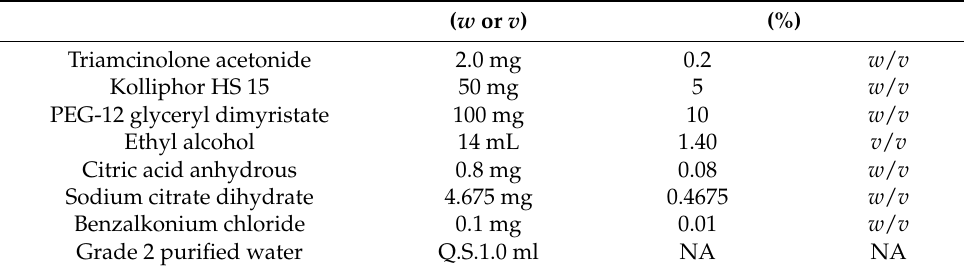
Table 1. Composition of triamcinolone acetonide-loaded liposome formulation (1 mL). ( w or v ) (%) Triamcinolone acetonide 2.0 mg 0.2 w / v Kolliphor HS 15 50 mg 5 w / v PEG-12 glyceryl dimyristate 100 mg 10 w / v 14 mL